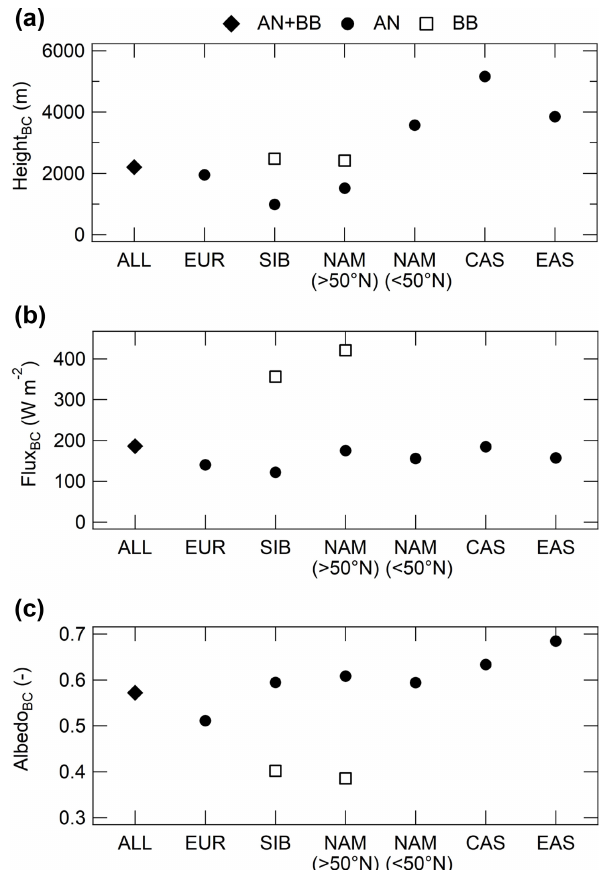
Figure 13. (a) Mean height (above sea level) (Height BC ), (b) mean solar radiation flux at the TOA (Flux BC ), and (c) mean surface albedo (Albedo BC ) weighted by BC concentrations in the Arctic (Eqs. 3–5) for total BC (ALL) and BC from eight major sources (six anthropogenic (AN) sources and two biomass burning (BB)